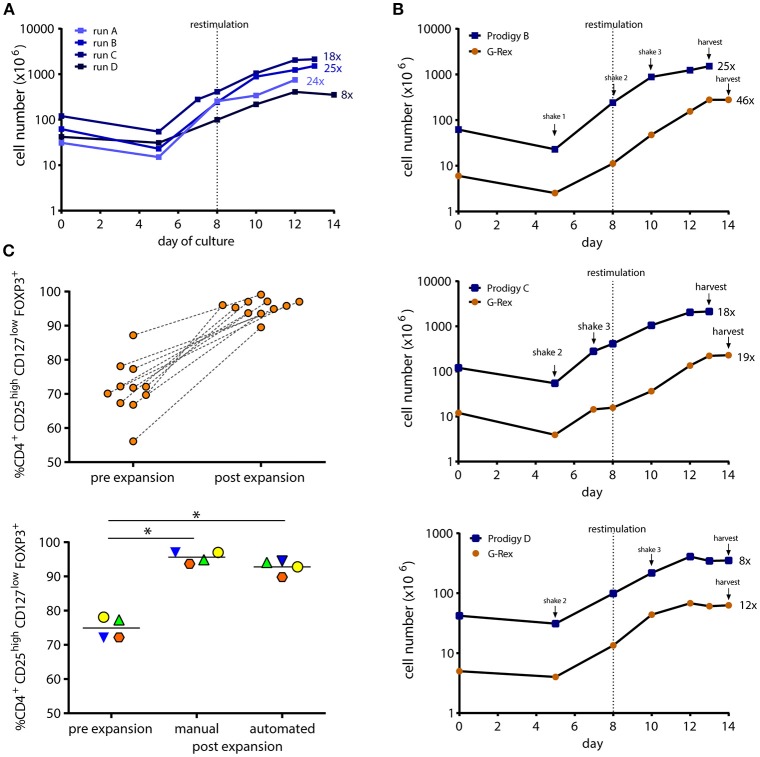
Growth curves and purity of automated closed-system vs. manually manufactured Treg. Clinical grade isolated Treg were cultured for 12–14 days in the CliniMACS Prodigy® or G-Rex10 culture devices with high dose IL-2, rapamycin, and ExpAct Treg expansion beads. (A) Expansion curves of four automated CliniMACS Prodigy® cultures during process development and optimization. (B) The optimized automated expansion process was compared to parallel manual G-Rex®10 culture starting with 1/10 of CliniMACS Prodigy® seeding cell number of the same isolated Treg pool. Bead restimulation and agitation modes are depicted. Results from 3 donors are shown. Numbers followed by x indicate fold expansion values. (C) Treg purity before and after manual or automated expansion culture. Treg phenotype was analyzed by flow cytometry as CD4+CD25highCD127lowFOXP3+. Shown is the percentage of Treg of all CD45+ for manually manufactured cultures (upper panel, n = 11,*p < 0.05) and manual vs. CliniMACS Prodigy® expanded cultures (lower panel, n = 4,*p < 0.05). Matching symbols indicate same starting material.